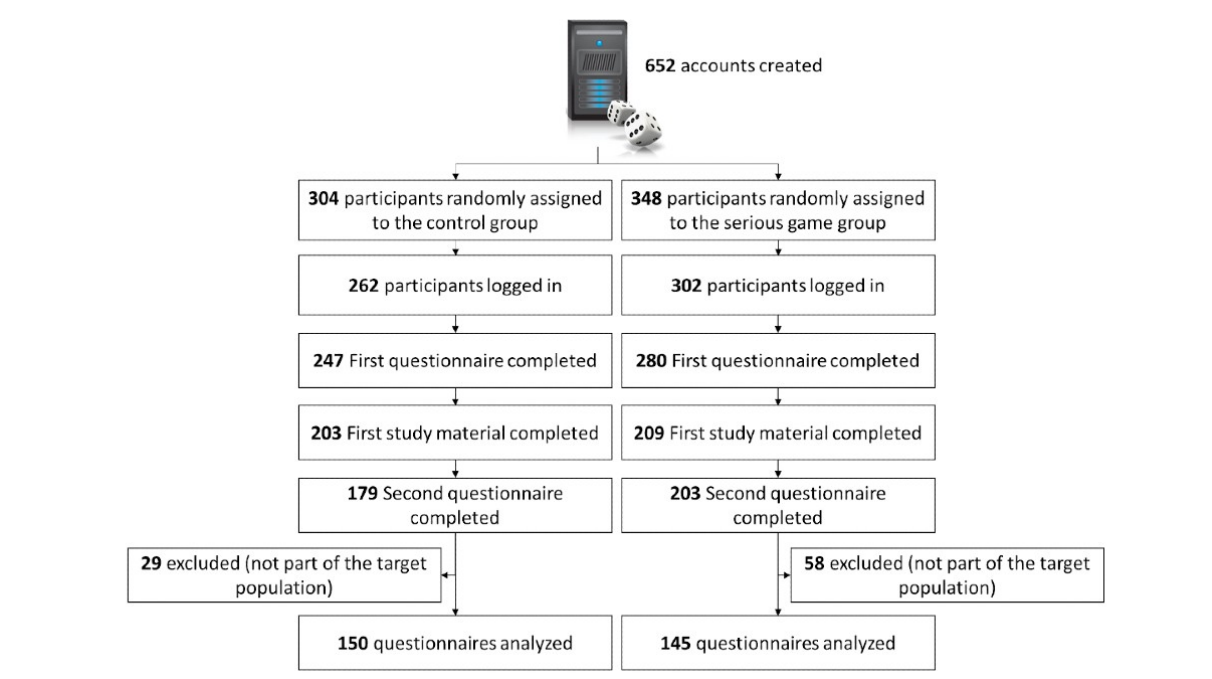
Figure 9. Study flowchart.